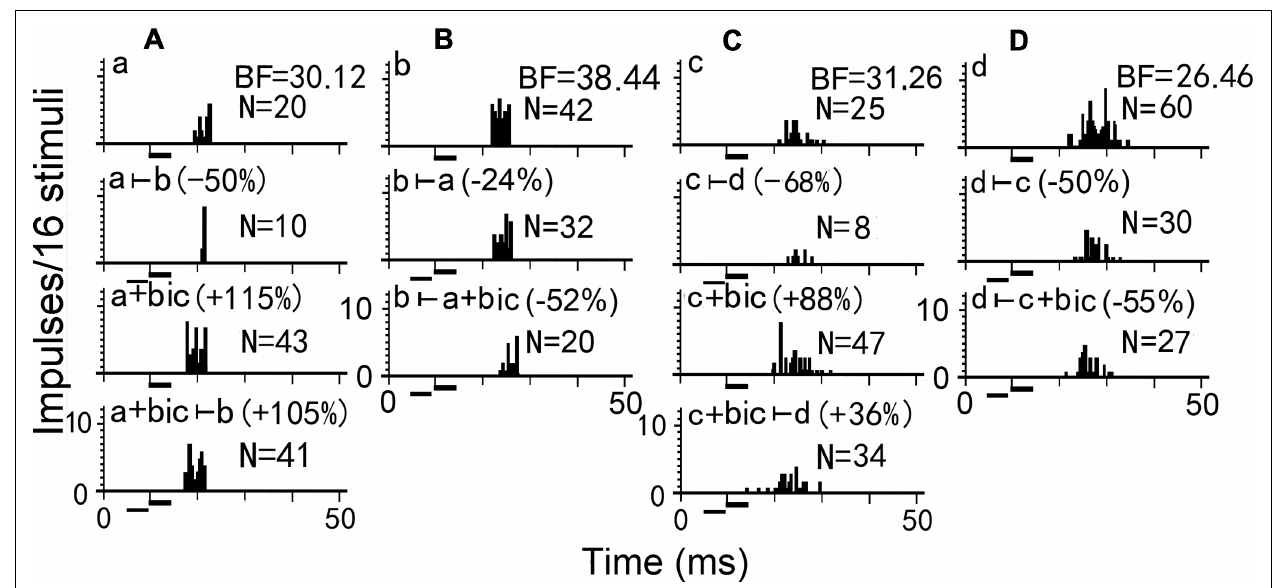
FIGURE 2 |Two-tone suppression on responses of two pairs of simultaneously recorded IC neurons before and during bicuculline (bic) application. Presentation of a counterpart sound decreased the firing rates of each IC neuron in the (A,B) pair or (C,D) pair (Aa, Bb, Cc, Dd vs Aa (cid:2) b, Bb (cid:2) a, Cc (cid:2) d, Dd (cid:2) c).When bicuculline was applied to neurons A and C, the number of impulses increased (Aa vs Aa + bic, Cc vs Cc + bic).The presentation